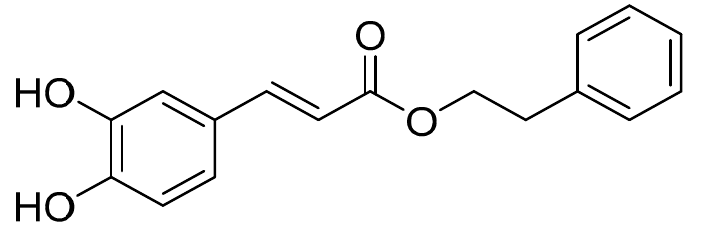
Figure 1. Chemical structure of CAPE.